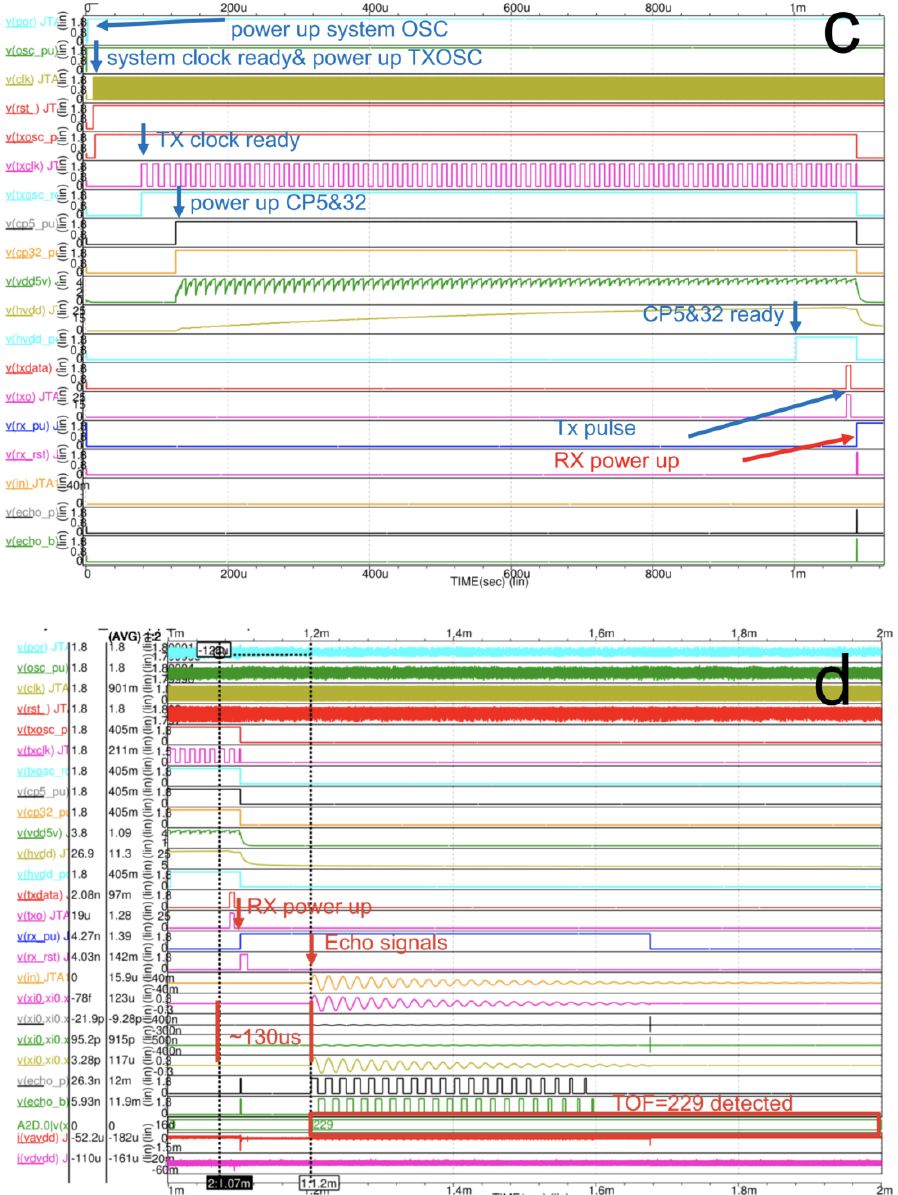
Figure 5. Charge pump, transmitter and receiver circuits. ( a ) The relationship between the output voltage of the charge pump circuit and the driving frequency. ( b ) The function block diagram of TX. Signal simulation of ( c ) the drive circuit and ( d ) the receiver circuit.